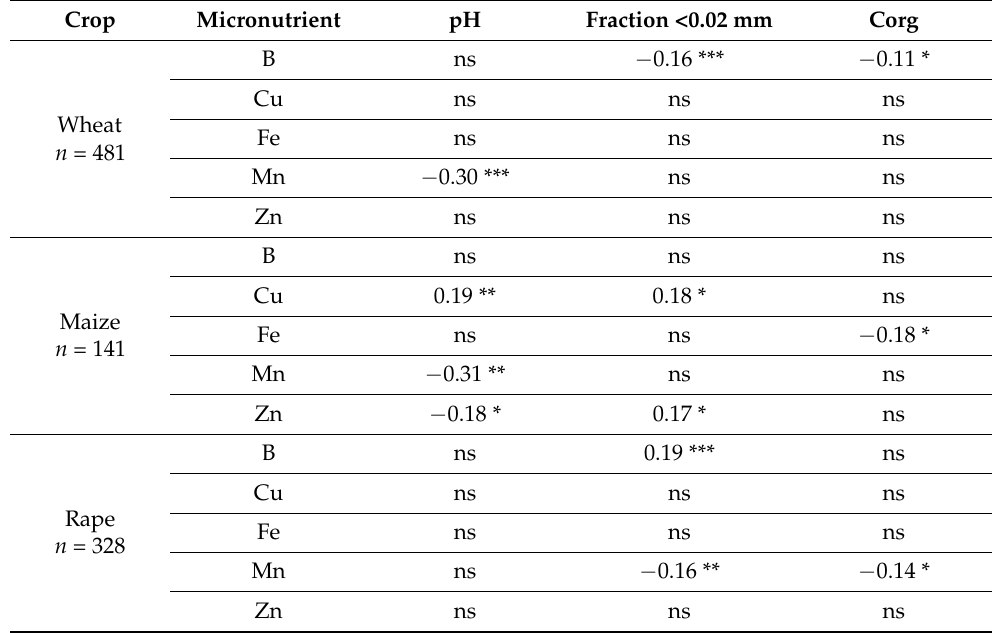
Table 7. Pearson correlation coefficient (r) between micronutrient concentration in shoots and soil